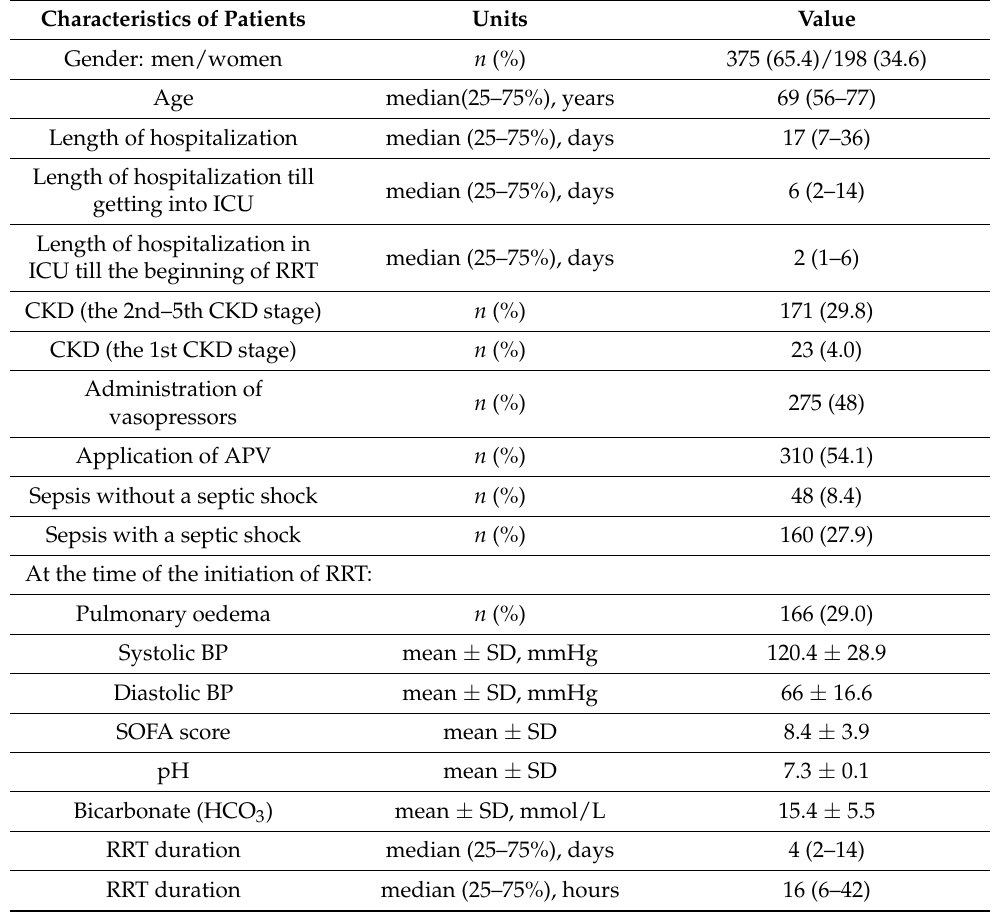
Table 1. Demographic and clinical characteristics of study